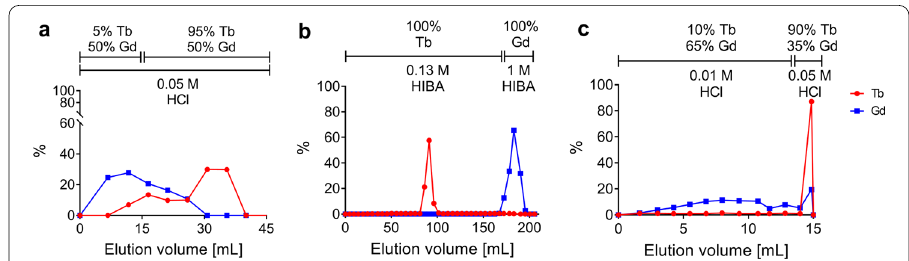
Fig. 4 Representative elution profiles of terbium and gadolinium from DGA column using 0.05 M HCl ( a ), from Sykam column using 0.13 M and 1 M α-HIBA ( b ) and from LN3 column using 0.01 M HCl and 0.05 M HCl ( c ). In this set of experiments, the columns were loaded with lanthanide metal tracers, which were subsequently eluted with the eluents mentioned. The sample aliquots were measured by means of